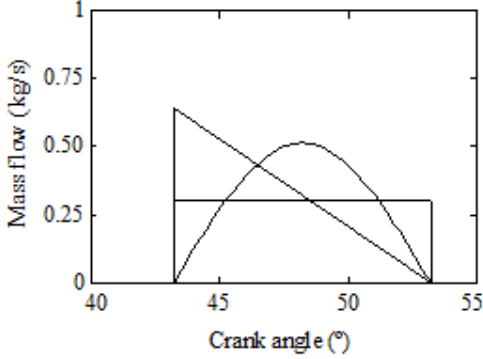
Figure 7. Ammonia injection rates analyzed.